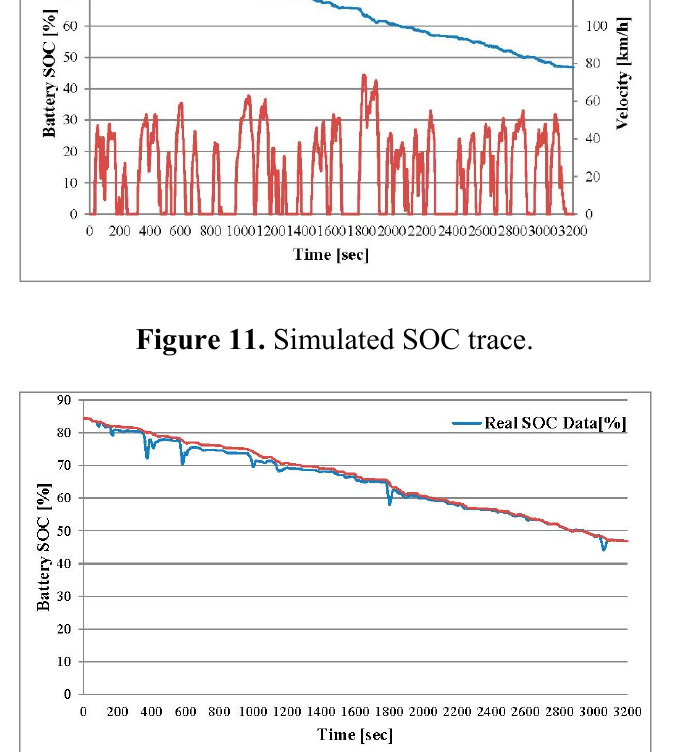
Figure 12. Direct comparison of SOC traces from experiment and